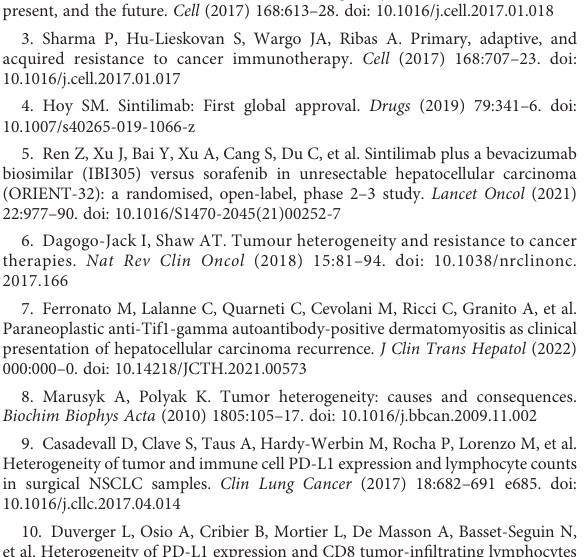
SUPPLEMENTARY FIGURE 1 The tumor microenvironment of primary and recurrent tumors. In the primary tumor in the liver, IHC showed positive b -catenin expression and in fi ltration of T cells, B cells, macrophages, and natural killer cells. In the metastasis in the lung after Sintilimab treatment, IHC showed positive b - catenin expression and in fi ltration of T cells, B cells, macrophages, natural killer cells, and a few regulatory T cells. CD3, T cell marker; CD4, T helper cell marker; CD11c, dentritic cell marker; CD20, B cell marker; CD 57, natural killer cell marker; CD68, macrophage marker; Foxp3, regulatory T cell marker. Foxp3 staining is indicated by red